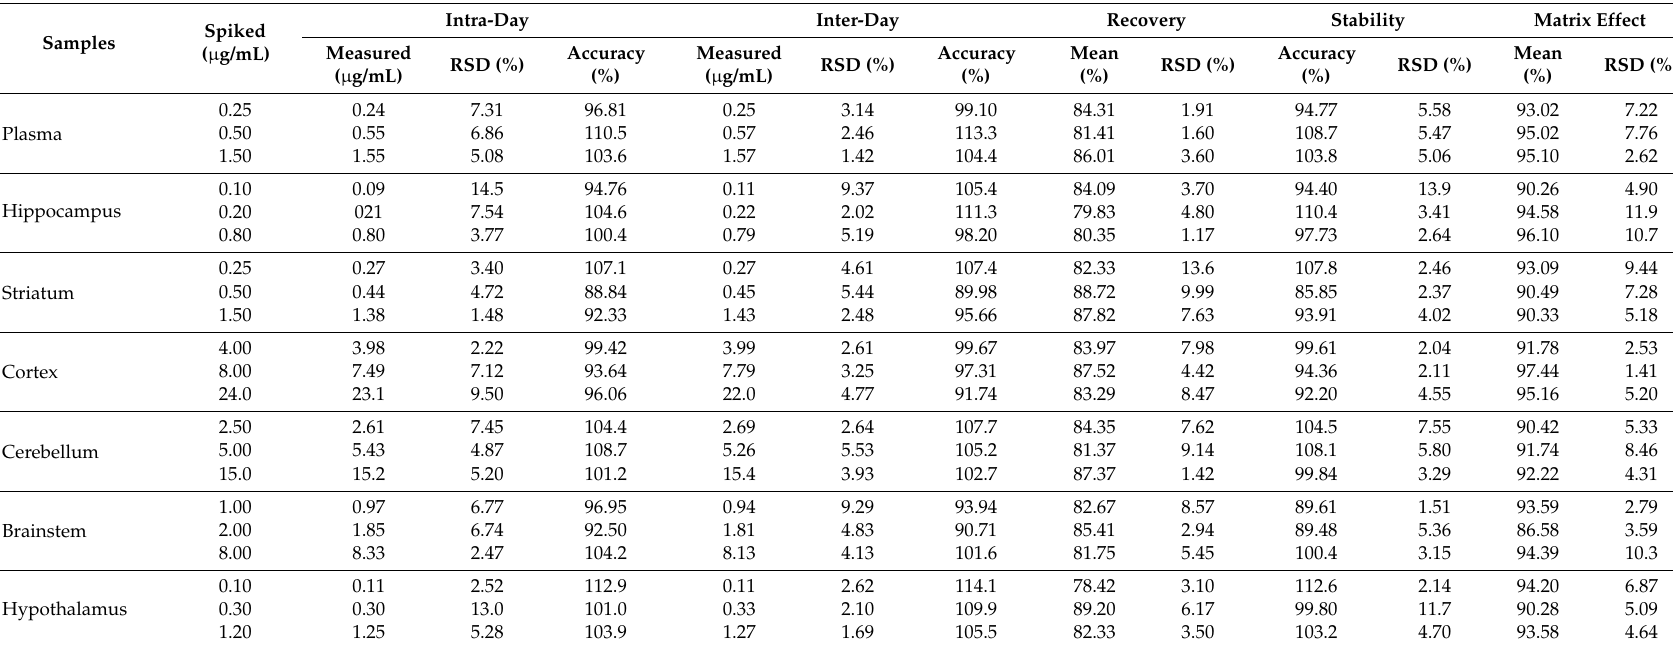
Table 2. Extraction recovery, stability, matrix effect, intra- and inter-day accuracy, and precision of DDIE in rat plasma and cerebral nuclei samples.